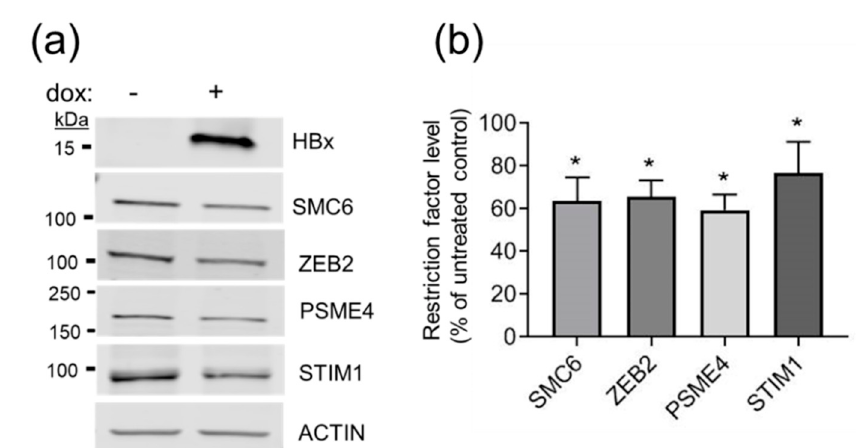
Figure 4. Expression of HBx reduces steady-state levels of putative restriction factors: ( a ) Representative western blot of plasmid-transfected HEK293T cells ± treatment with dox to induce the expression of HBx, as described in the Materials and Methods section. Cell lysates were separated by SDS-PAGE; were transferred to nitrocellulose filters; and were blotted using antibodies against restriction factors SMC6, ZEB2, PSME4, and STIM1 (Supplementary Table S1). Protein levels were normalized to actin levels (bottom panel). Comparison of treated cells with untreated cells revealed the impact of HBx expression. ( b ) Graphical representation of western blot results from three independent experiments: The level of each restriction factor in the absence of HBx was set to 100% and compared to the level of that same protein in the presence HBx. Significance was determined by student t test using GraphPad Prism Version 8.1.2. Asterisks indicate p < 0.05.